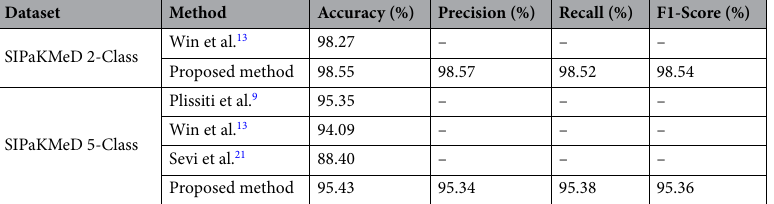
Table 7. Comparison of the proposed framework with some state-of-the-art methods on the SIPaKMeD pap smear dataset.